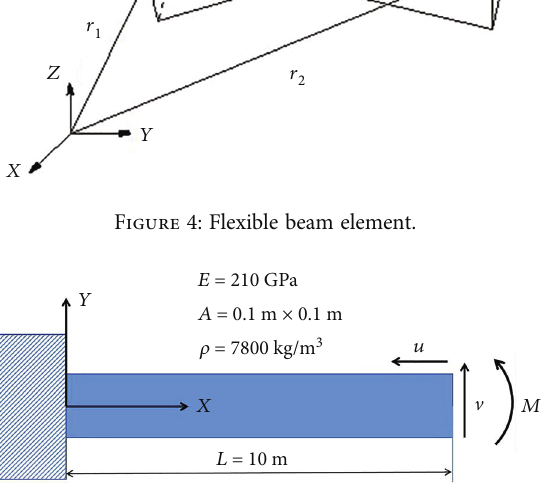
Figure 5: Cantilever beam undergoes bending load.